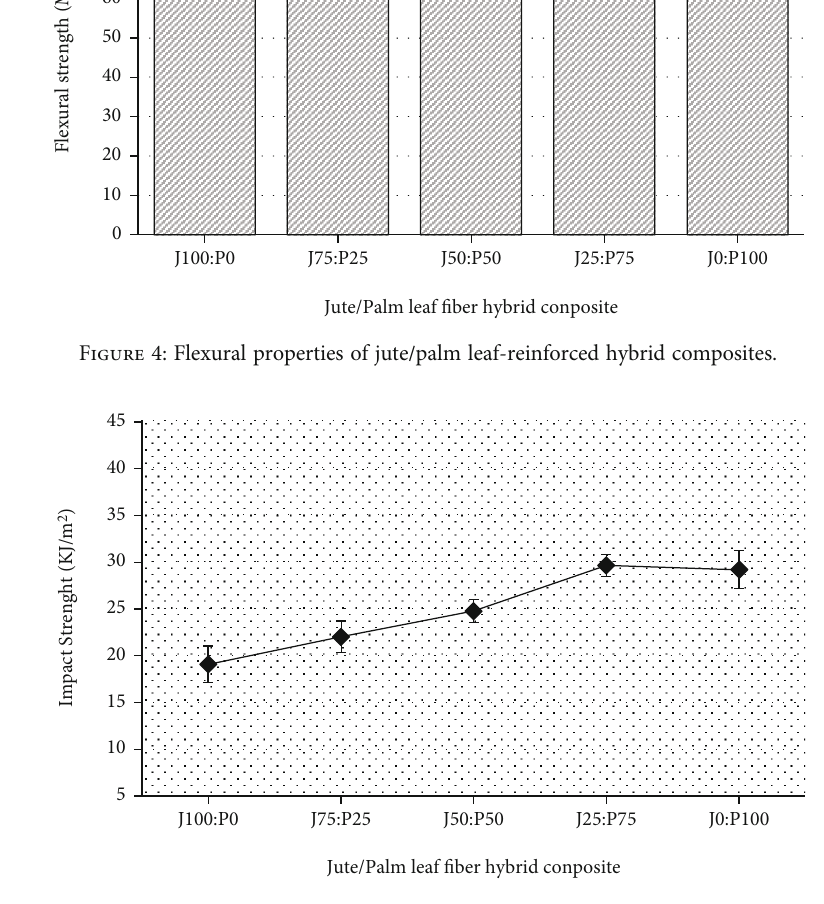
Figure 5: Impact properties of jute/palm leaf-reinforced hybrid composite.